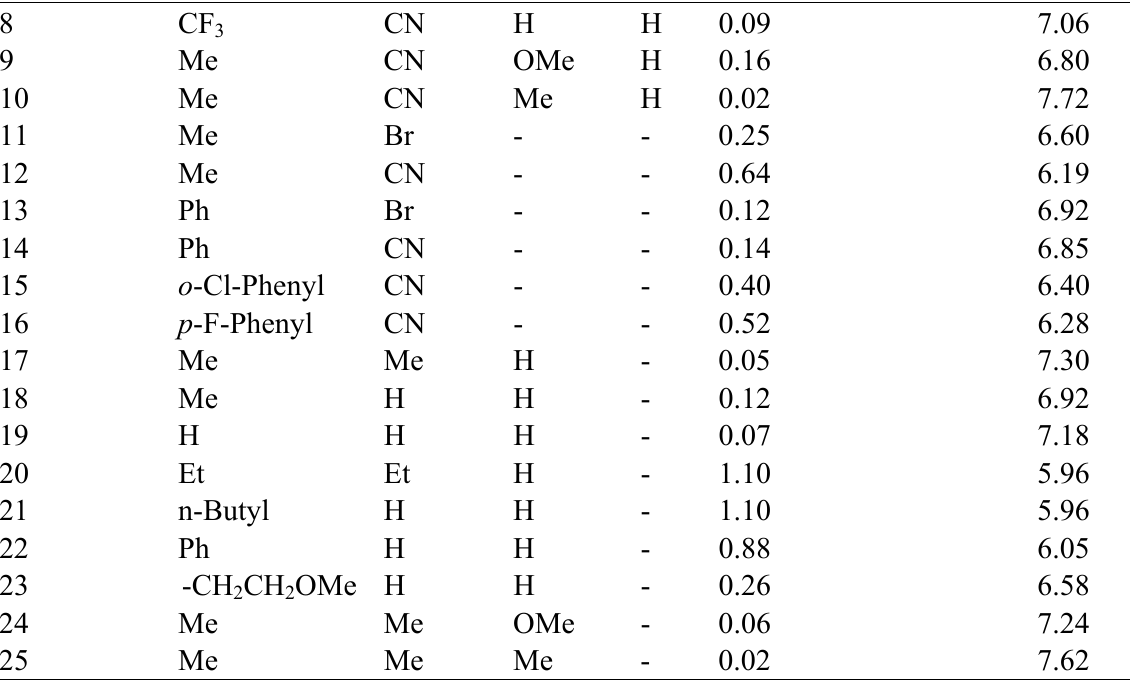
Table 2. Structures and biological activities of the furyl and